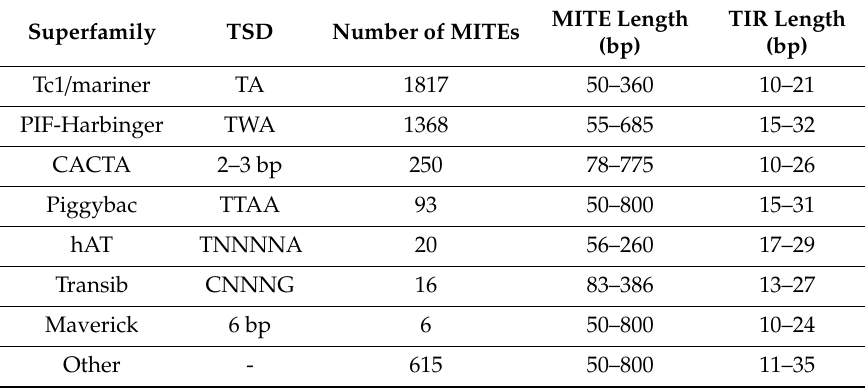
Table 2. Distribution of MITEs identified in the H. armigera